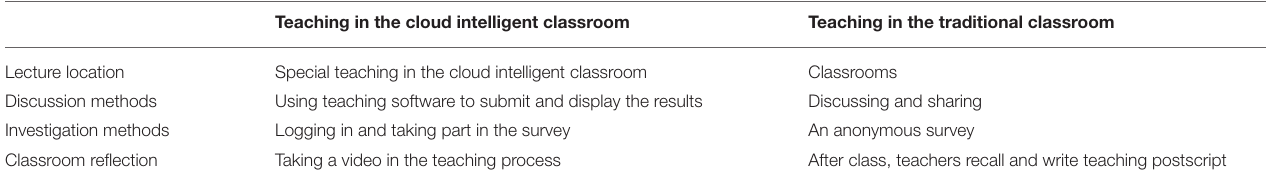
TABLE 2 | Educational practice